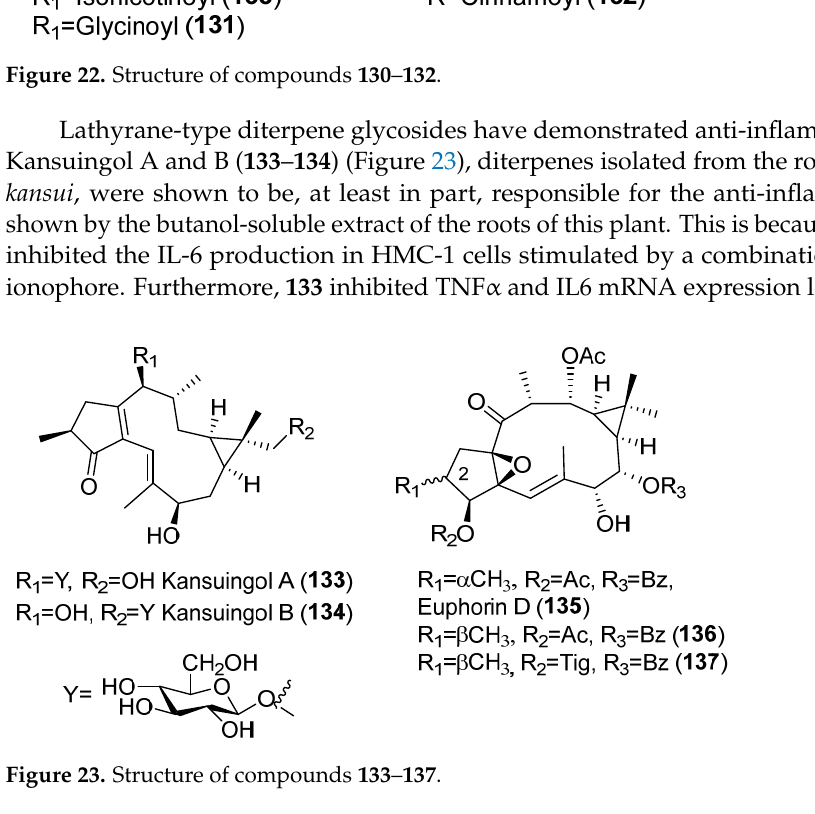
Figure 24. Structure of Jatrocurcasenones H and I. Mode of Action The ability to produce inflammatory cytokines, including IL-1 β and IL-6, when cells were treated with EFL 30 ( 113 ) (Figure 18) was evaluated; the results showed a significantly elevated production of them in the cell supernatant of LPS-induced RAW264.7. The inves- tigation of the mechanism of modulation of pro-inflammatory cytokine response showed that 113 reduced the expression level of inducible nitric oxide synthase (iNOS) and NF- κ B in a dose-dependent manner. In addition, compound 113 reduced the phosphorylation of I κ B α and eliminates LPS-induced nuclear translocation of NF- κ B. These results indicate that 113 exerts its anti-inflammatory activity by interfering with the phosphorylation of I κ B α , thereby blocking the expression and nuclear translocation of NF- κ B and reducing the expression of iNOS [16].